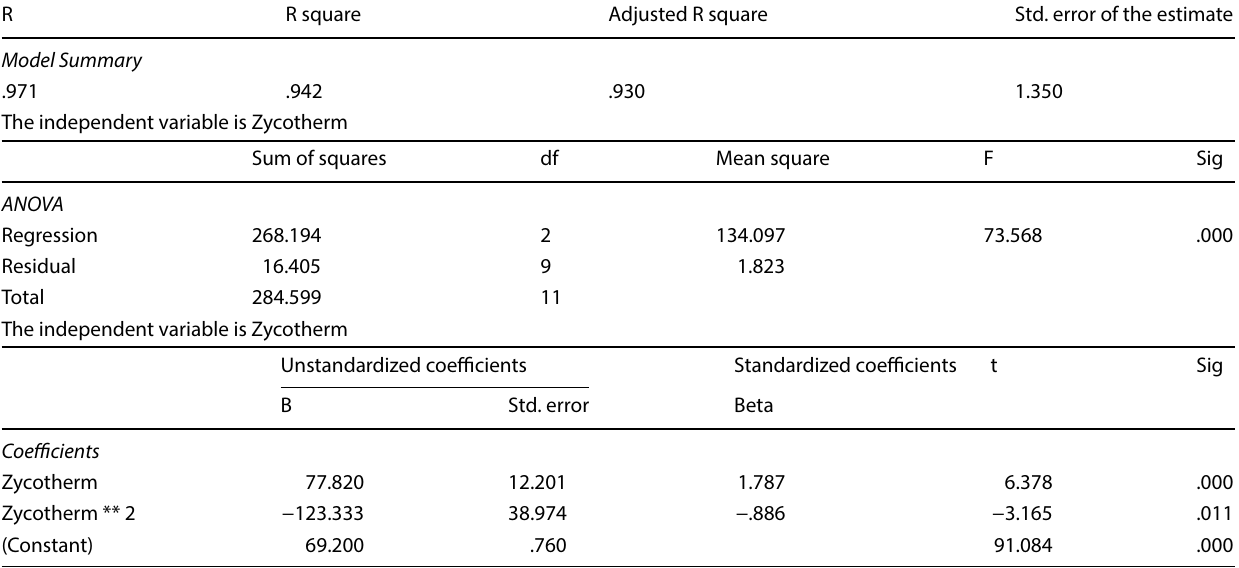
Table 5 Statistical analysis of TSR regression model—Sodium Chloride solution